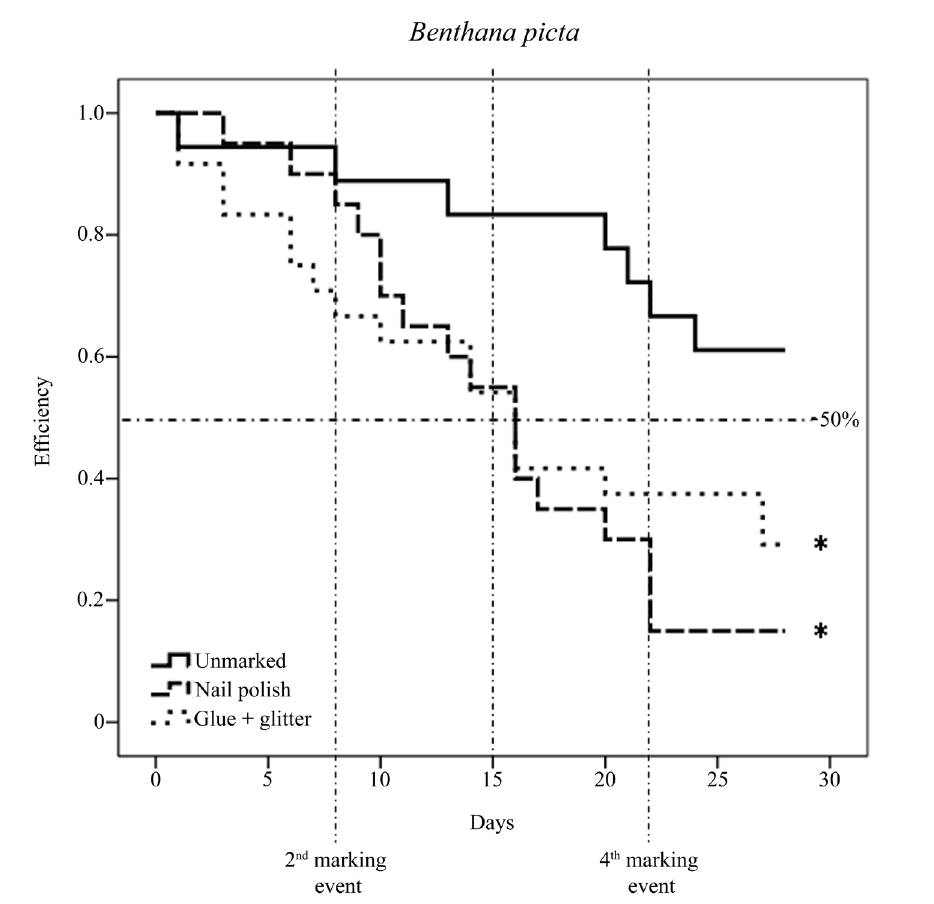
Figure 4. Kaplan-Meier curves for the external marking efficiency (durability) of the two materials tested on Benthana picta for 28 days of observation. Vertical dotted lines indicate the second, third and the forth event of external marking (8 th , 15 th and 22 th days, respectively). Horizontal dotted line delimits the 50% of remaining marked individuals. * indicates statistical significance.